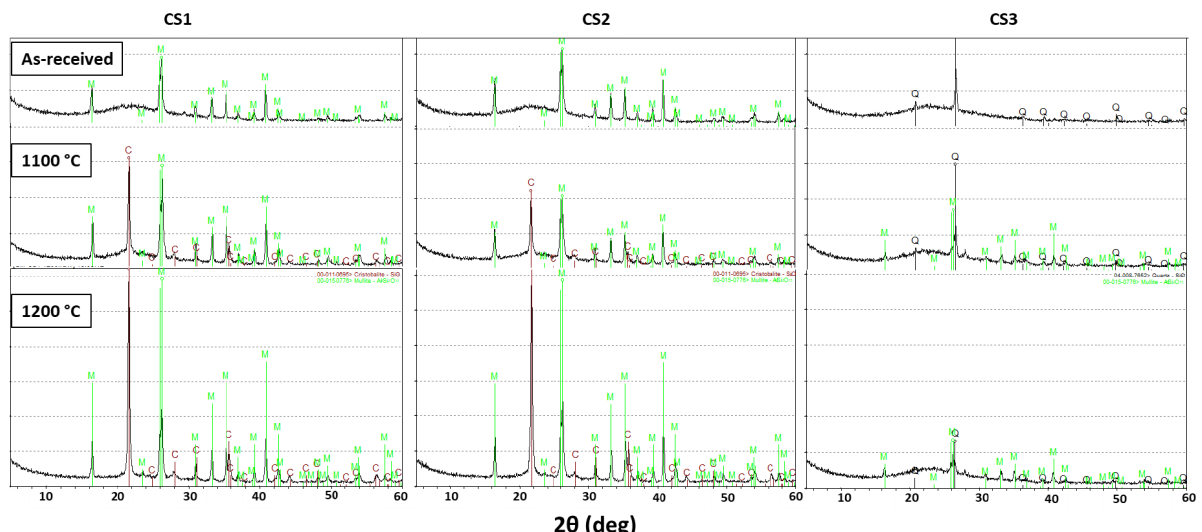
Figure 4. X-ray diffractograms of the CS at as-received and heat-treated conditions. Phase designa-